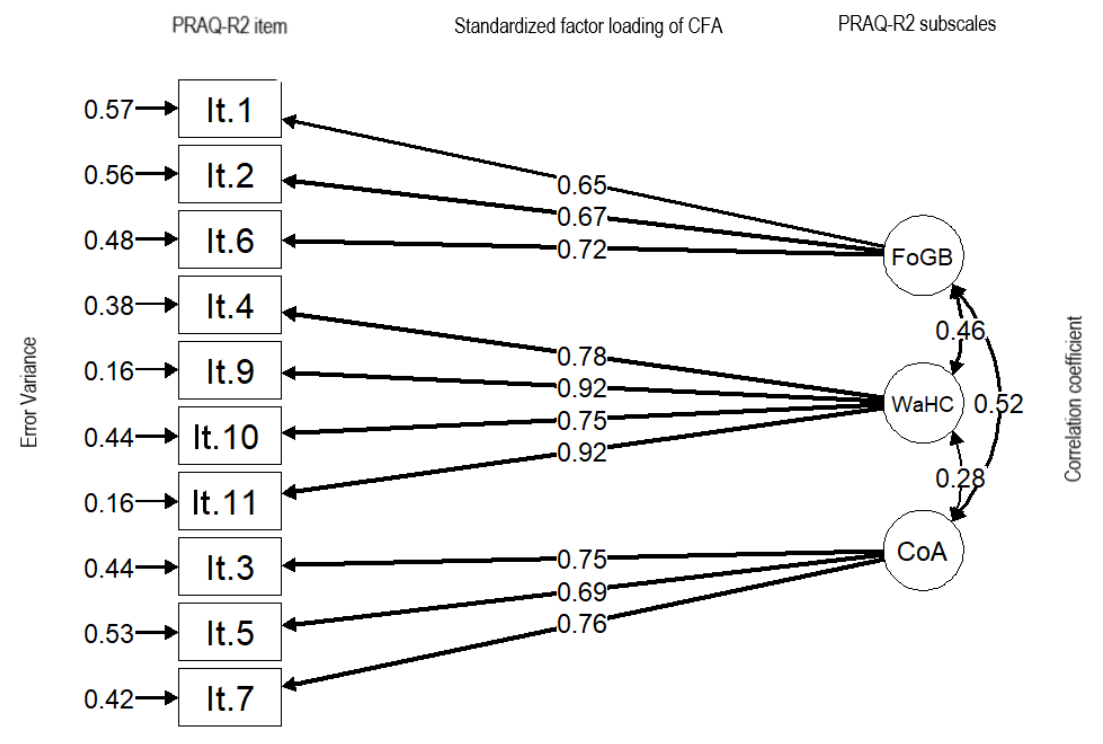
Figure 1. Standardized parameter estimates for the factor structure of the PRAQ-R2. FoGB: fear of giving birth; WaHC: worries about bearing a handicapped child; CoA: concern about one’s appearance.